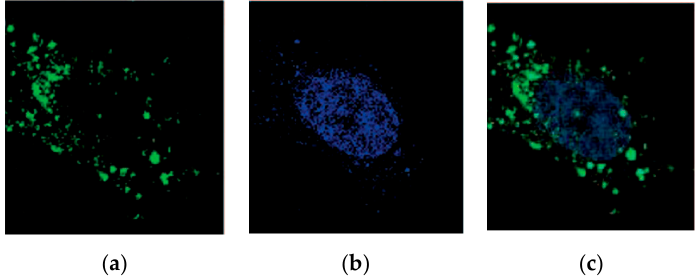
Figure 5. ( a ) Confocal fluorescence imaging of G 7 TEA-core dendrimer-mediated cellular uptake of siRNA using a non-silencing siRNA sequence labeled with the green fluorescent dye Alexa 488. ( b ) Blue fluorescence images of a nucleus of the same cells stained by TOPRO-3. ( c ) Merged fluorescent images of a and b confirming the exclusive cytoplasm localization of the dendrimer/siRNA complexes. Adapted from [42] with permission of John Wiley and Sons. Pharmaceutics 2019 , 11 , x FOR PEER REVIEW